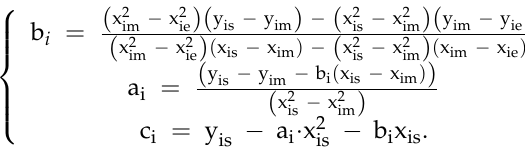
( h ) Figure 2. Error distribution of the first segment. ( a ) e (cid:2869)(cid:2878)(cid:2934) , c2 = 0.500; ( b ) e (cid:2869)(cid:2878)(cid:2934) , c2 = 0.501; ( c ) 1 √1 + x⁄ , c2 = 0.500; ( d ) 1 √1 + x⁄ , c2 = 0.498; ( e ) 1 (1 + x)⁄ , c2 = 0.500; ( f ) 1 (1 + x)⁄ , c2 = 0.498; ( g ) √1 + x , c2 = 0.500; ( h ) √1 + x , c2 = 0.498.